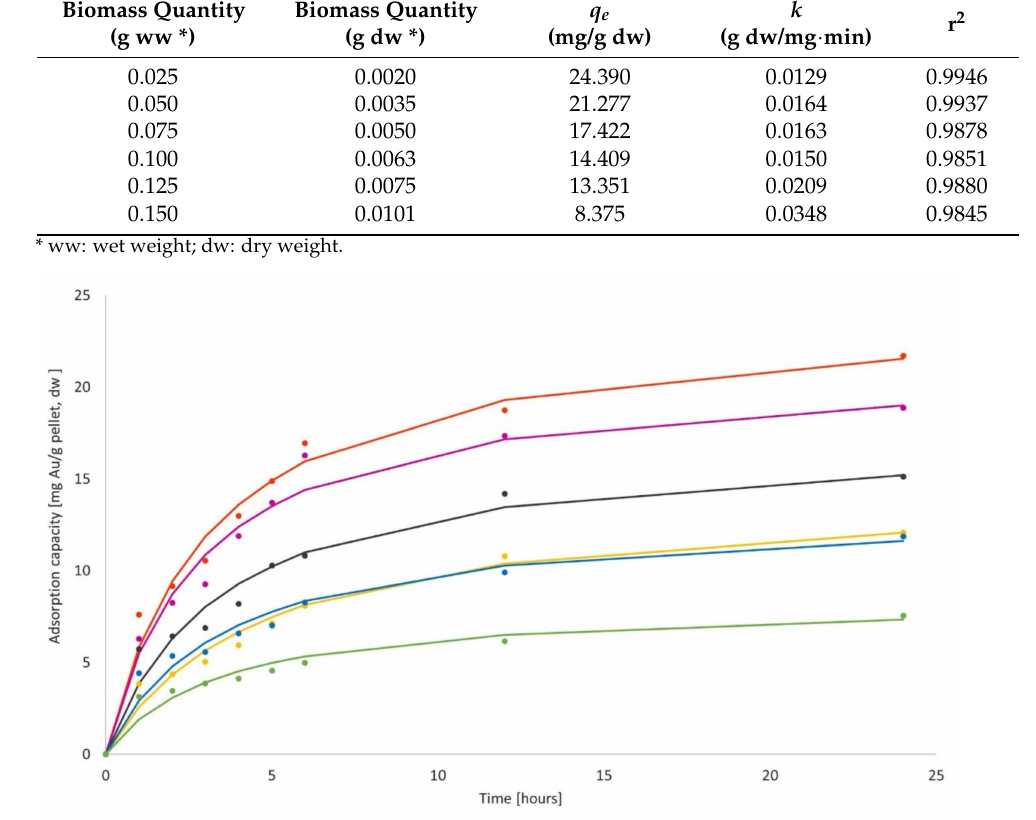
Figure 13. Au adsorbed on different quantities (dry weight) of Aspergillus tabacinus pellets. • : 0.0020